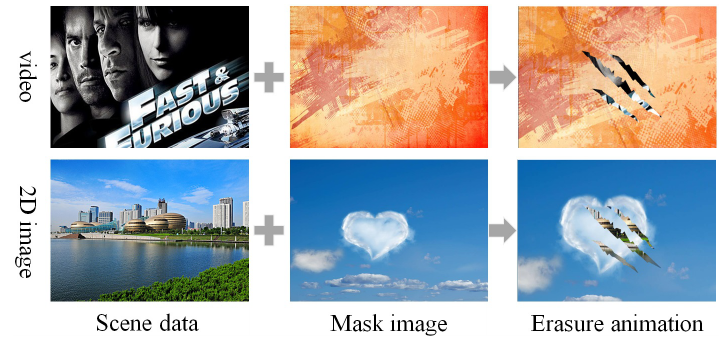
Figure 7. Erasure animations with different scene data and mask image data.